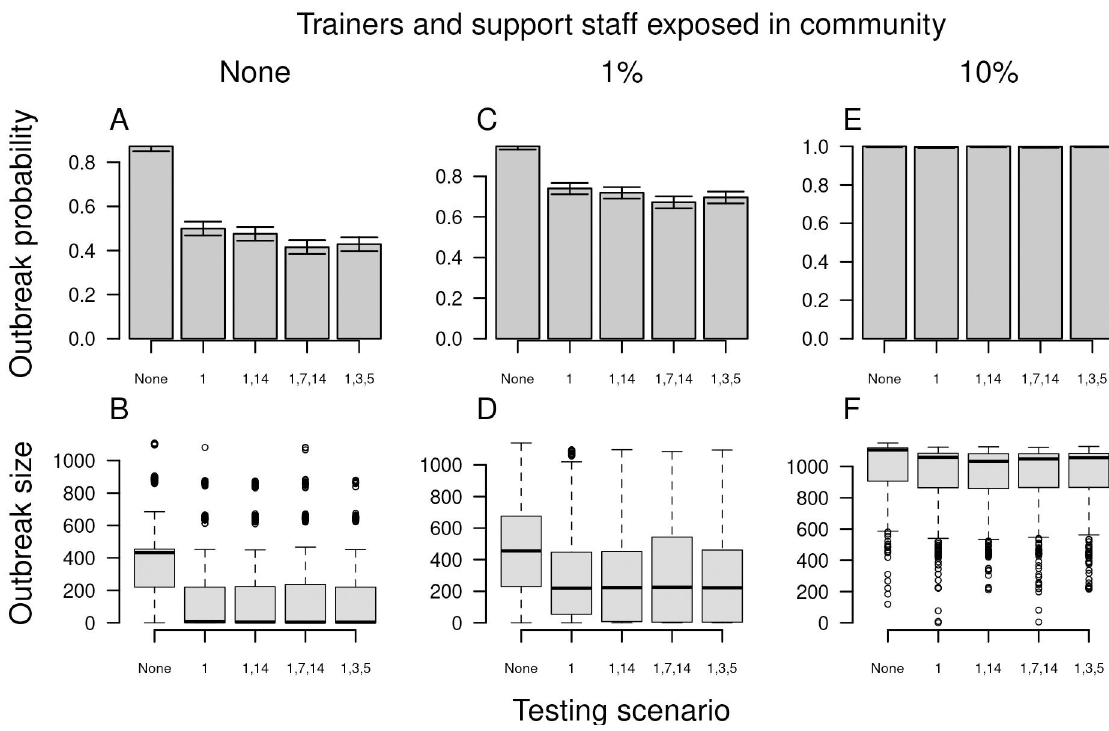
Fig 5. Outbreak probability (top) and size (bottom) in basic training as a function of alternative scenarios for testing trainees upon arrival (x-axis). Testing scenarios are labeled according to the day on which a test was administered to trainees following their arrival. From left to right, columns show increases from 0 to 0.01 to 0.10 of the probability that trainers and support staff were exposed to the virus in the community over the course of the 70-day training period. Error bars for outbreak probability indicate 95% Pearson-Clopper confidence